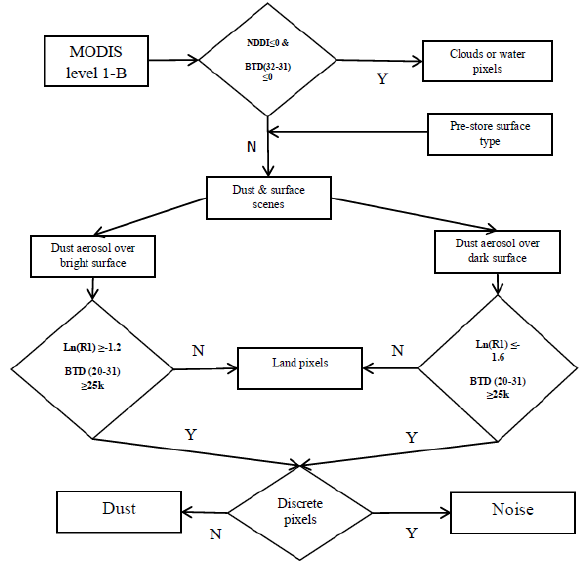
Figure 1. Xie approach for dust